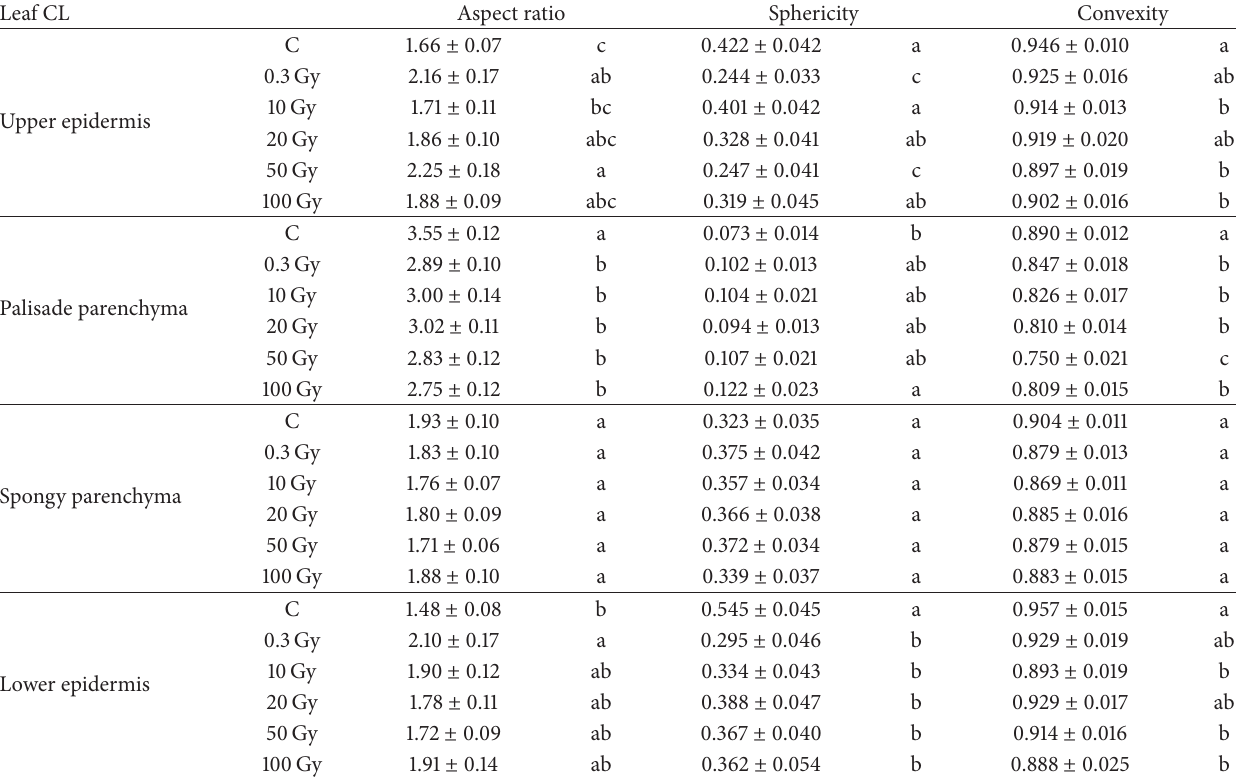
Table 2: Cell shape in different tissues of compound leaves of S. lycopersicum L. “Microtom”. Mean values ± standard errors are shown ( 𝑛 = 75 ). Different letters correspond to significantly different values according to multiple comparison tests ( 𝑃 < 0.05 ). Leaf CL